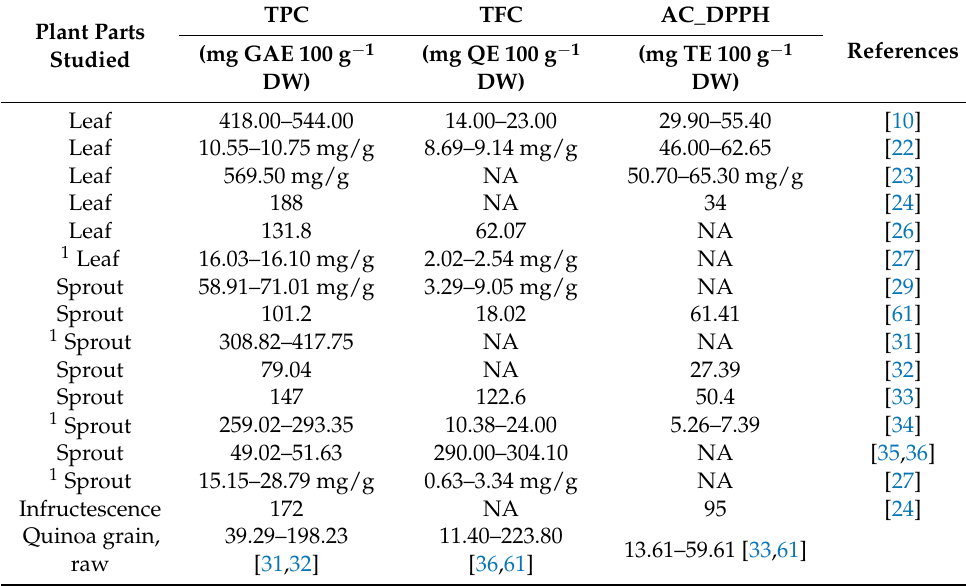
Table 4. Total phenolic content (TPC), total flavonoid content (TFC), and antioxidant capacity